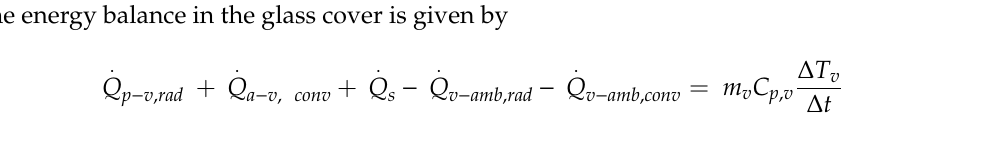
Figure 1. Heat transfer terms involved in the model.